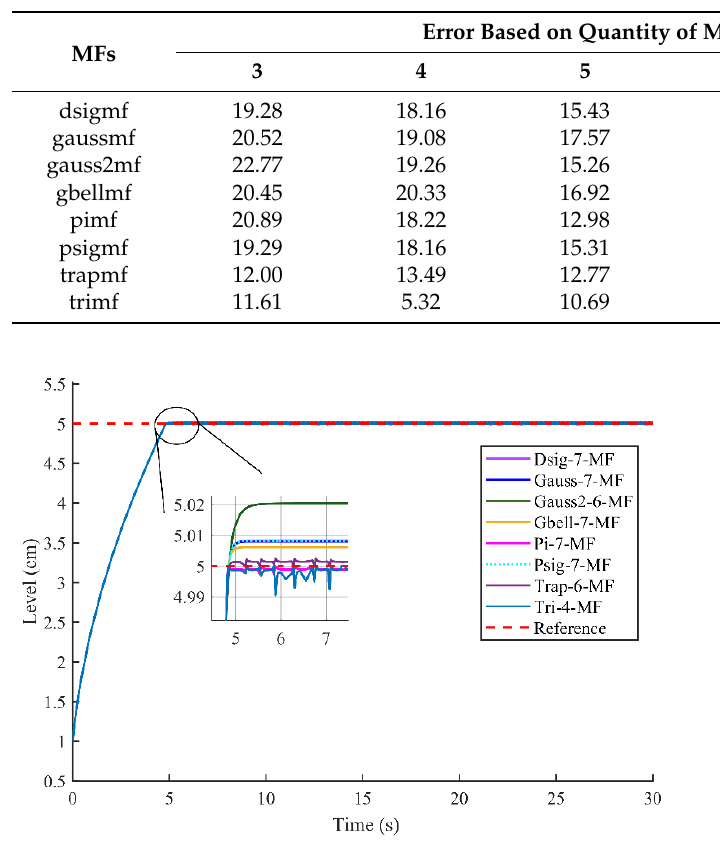
Figure 9. Performance comparison of different MFs.